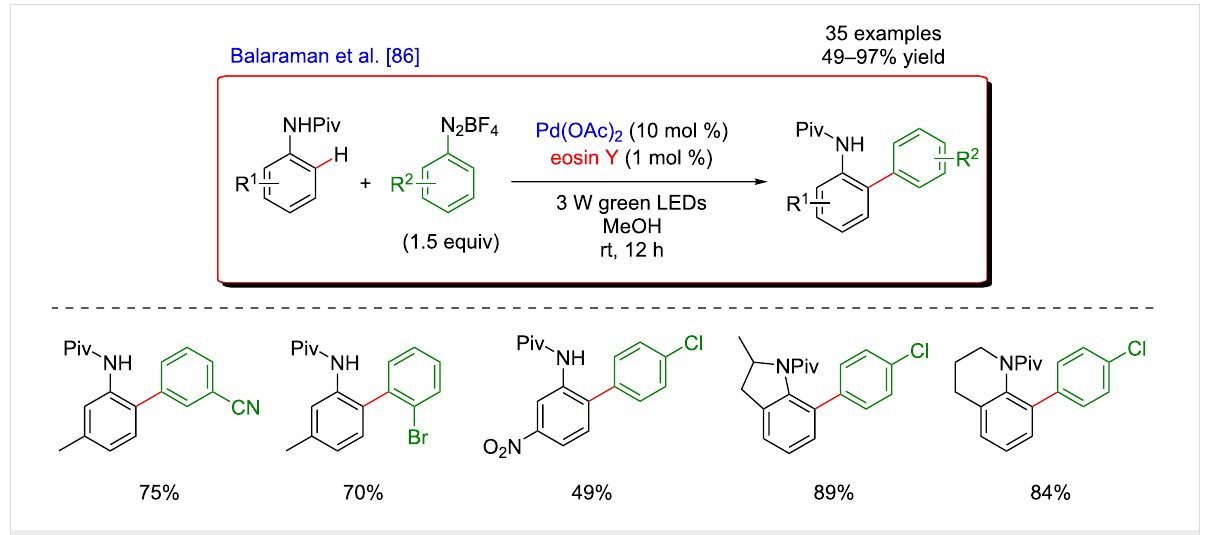
Figure 24: Direct arylation via dual catalytic system reported by Balaraman.